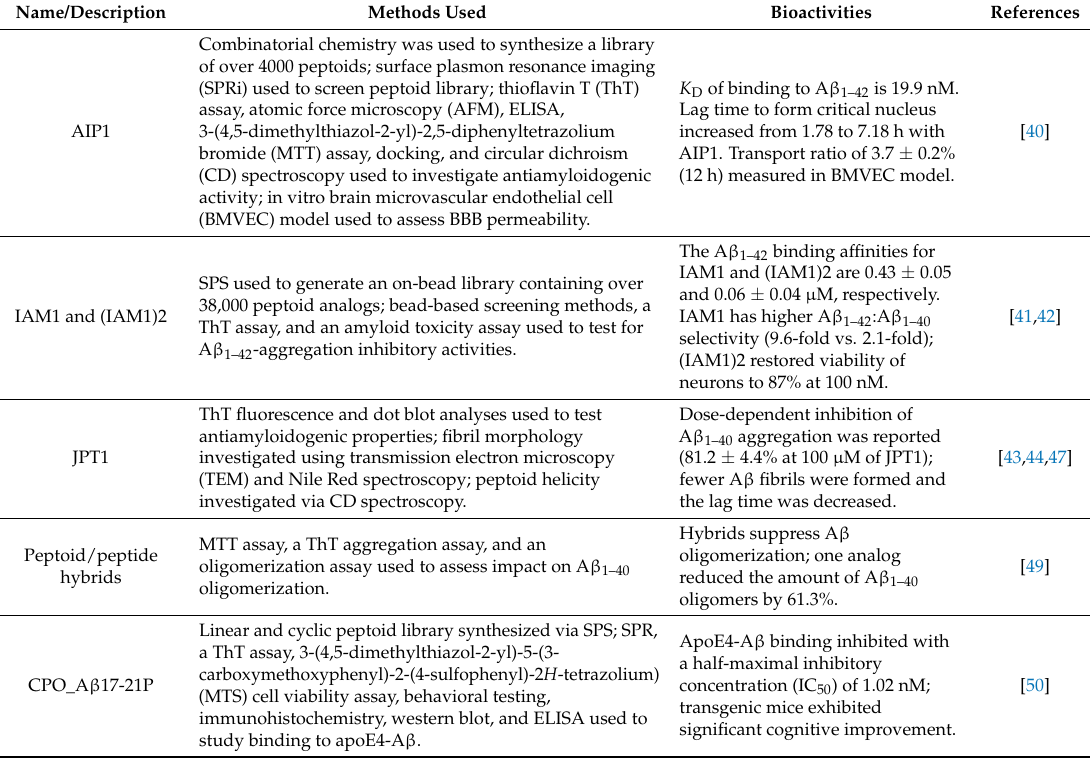
Table 1. Methods used and bioactivities reported for example antiamyloidogenic peptoids.